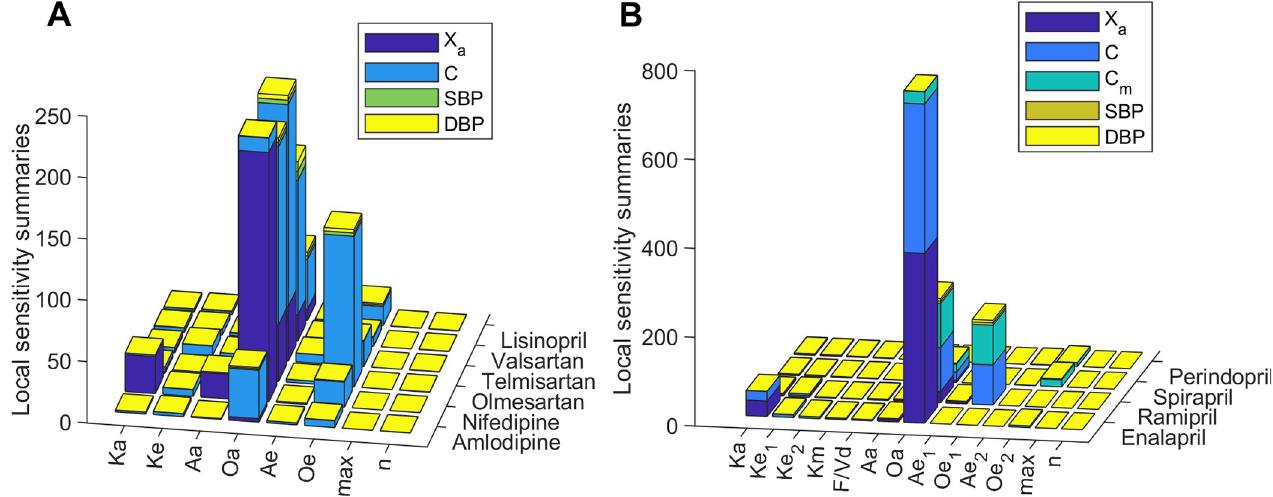
Fig 4. Local sensitivity summaries for non-prodrug models (A) and prodrug models (B). Sensitivity values are shown stacked for each model variable ( Xa : drug available to be absorbed, C : drug concentration, Cm : metabolite concentration, SBP : systolic blood pressure, DBP : diastolic blood pressure).